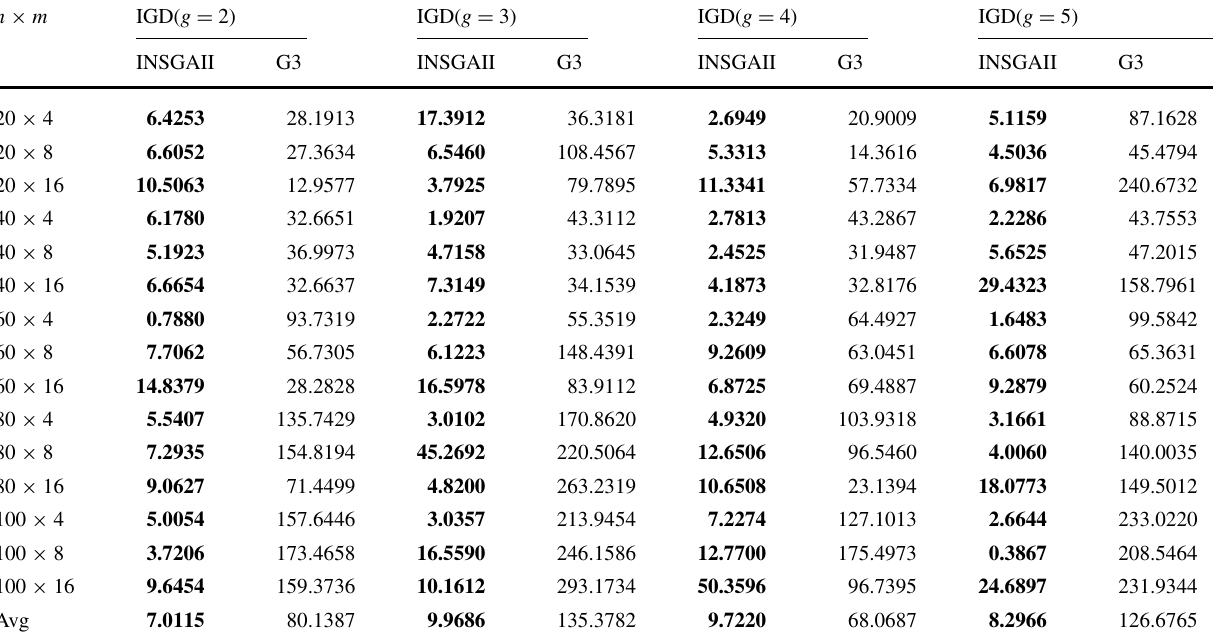
Table 9 Comparisons of the IGD values between INSGAII and